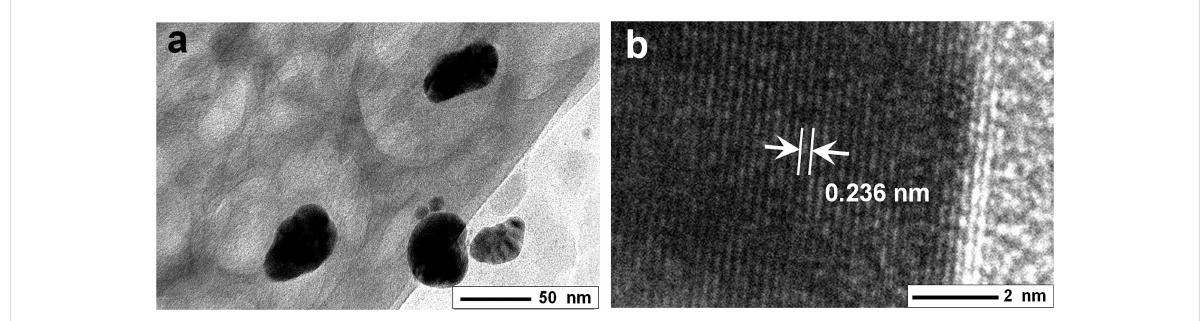
Figure 2: TEM image of Ag-NP/cellulose-NF–C (a), and HR-TEM image of an individual silver nanoparticle showing the lattice of metallic silver (b).